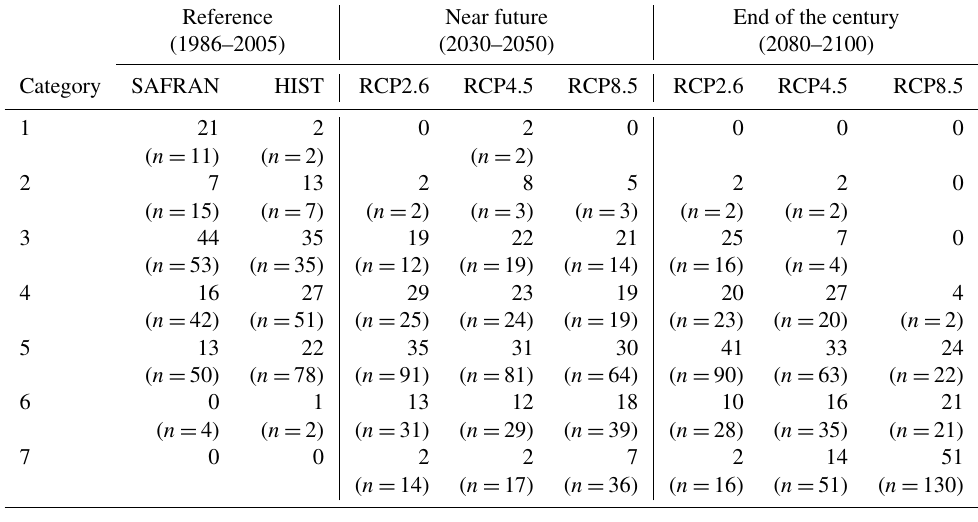
Table 2. Distribution of the total ski lift power (%) within reliability categories for distinct periods and scenarios (Fig. 4) with the corre- sponding number of ski resorts ( n ).